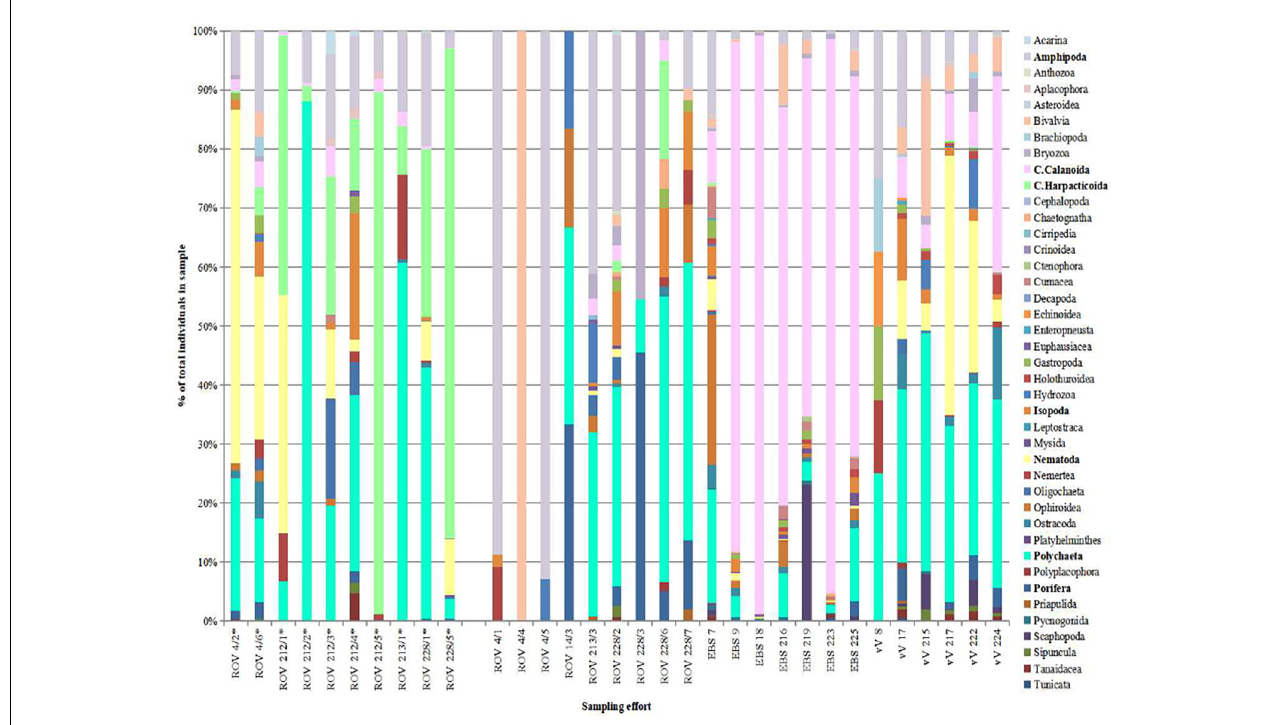
FIGURE 4 | Total percentage composition of taxonomic groups from biological samples taken in the Steinahóll region. *Denotes hydrothermally influenced sampling effort. Bold taxonomic names discussed in results/discussion.